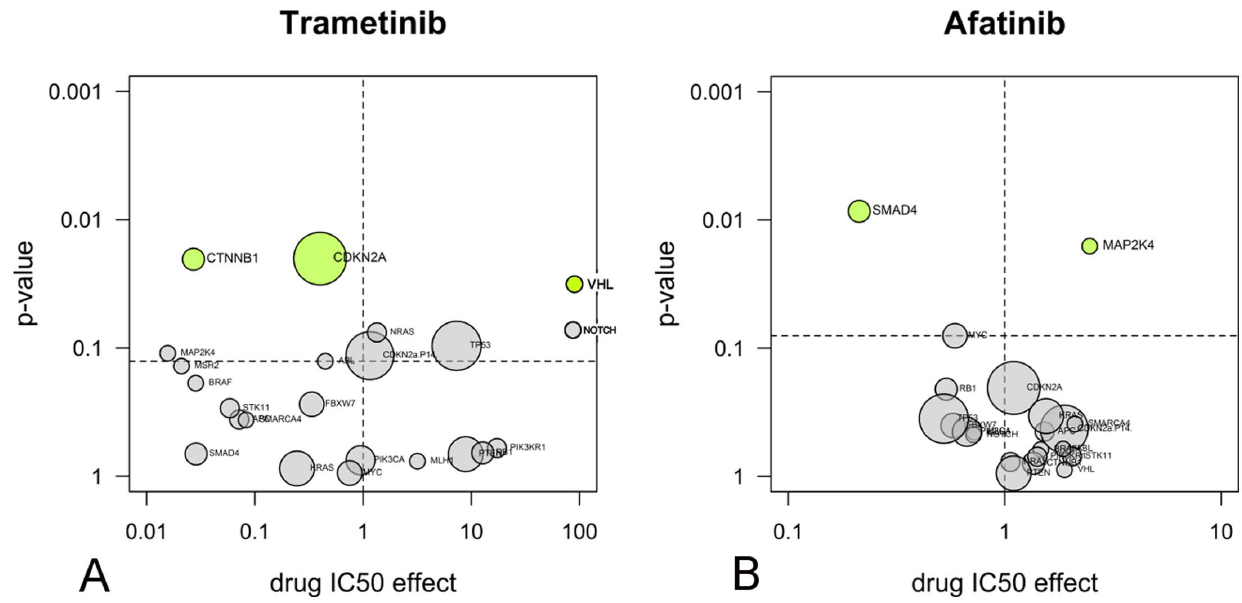
Figure 4. Anova analysis reveals novel drug response markers. A: the MEK inhibitor trametinib and B: the EGFR inhibitor afatinib. The volcano plots show the average IC 50 shift between mutant and non-mutant cell lines (x-axis) and the significance from the Anova test (y-axis). Significance was corrected for multiple-testing and all associations above the threshold level (dotted line) are coloured green. Areas of circles are proportional with the number of cell lines carrying